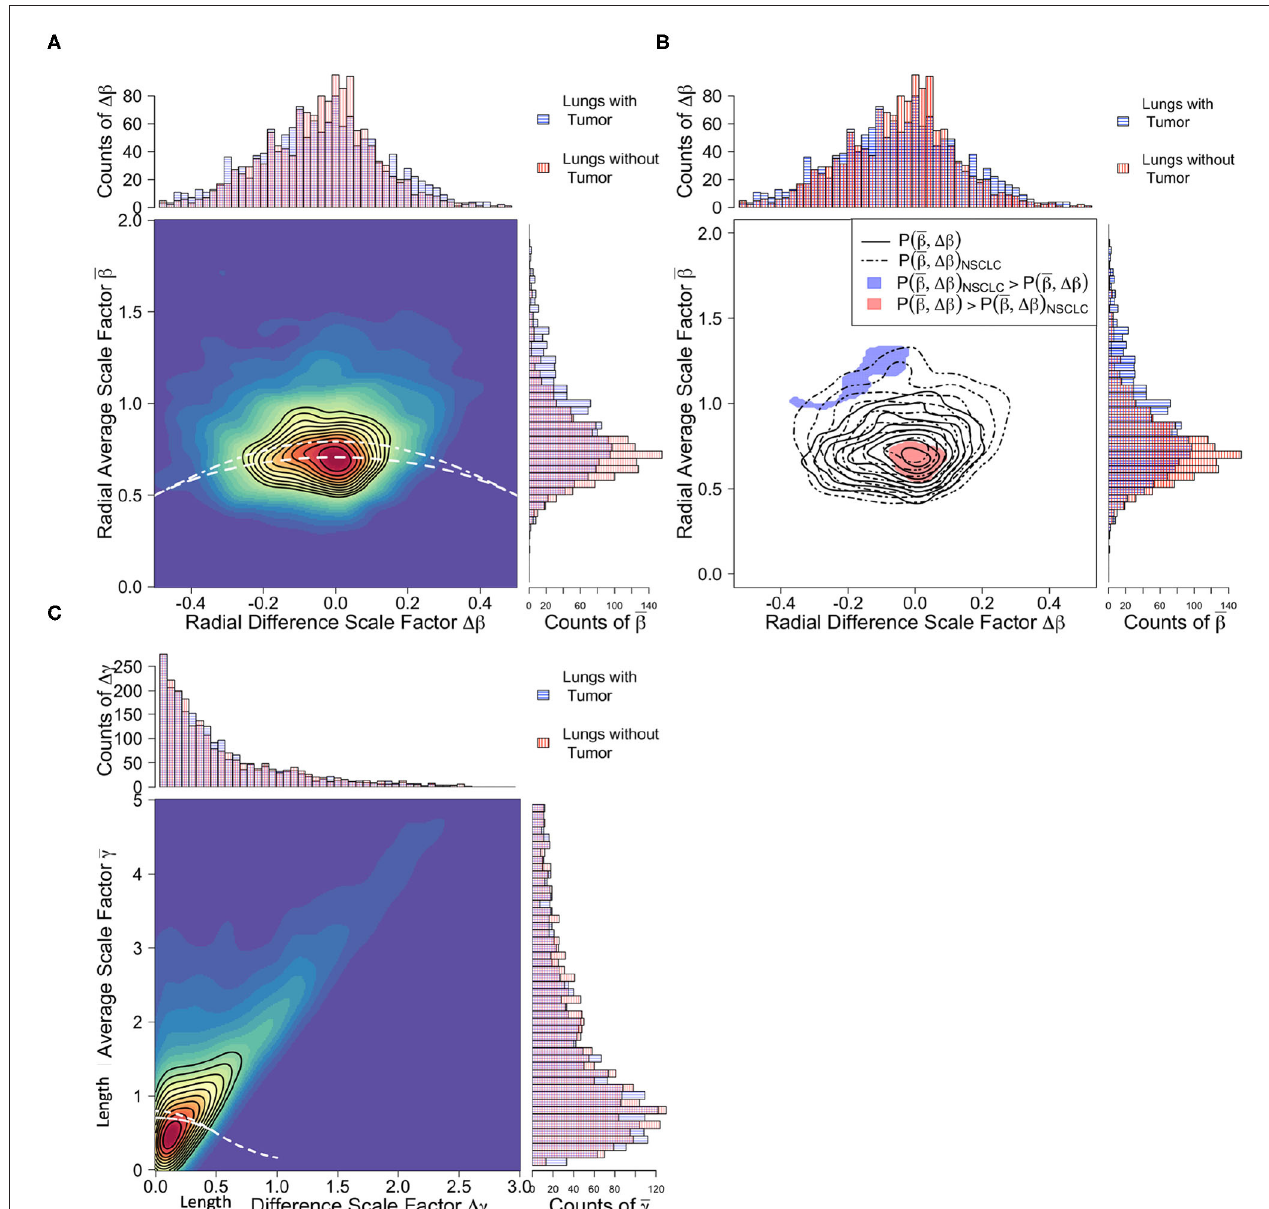
FIGURE 6 | Comparison of branching scale factors between tumor-supplying vessels (blue) and healthy tissue-supplying vessels (red). (A) Joint and marginal distributions for radial scale factors. White dashed lines correspond to predicted constraint equations for cubic, area-increasing scaling, Equation (3), (top line) and square, area-preserving scaling, Equation (2), (bottom line). Note that both categories of vessel groups closely follow area-preserving scaling, yet variation in the tumor-supplying vessel groups trend toward area-increasing scaling. (B) Significance contours identifying regions in the radial scale factor feature space responsible for differentiation. Unlike the radial scale factors, length scale factors (C) defined using canonical generation labeling do not result in significant differentiation between vessel groups.